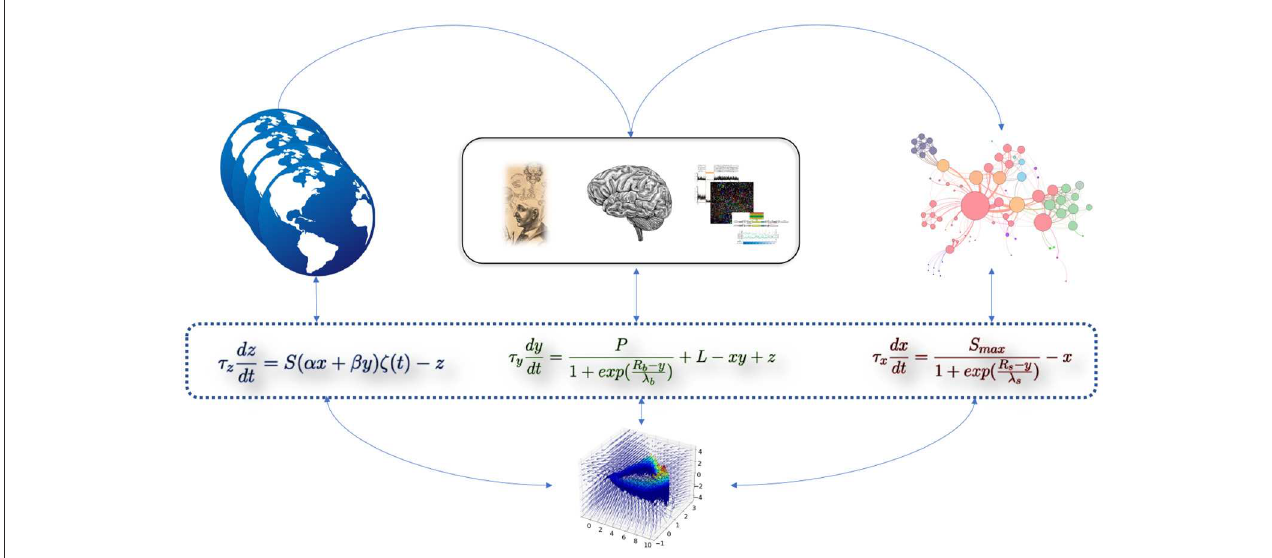
FIGURE1 Cartoon representation of the computational dynamical toy-model of psychiatric disorders. The three equations are intrinsically linked by their interacting variables. The equation on the left (variable z ) represents the effect of the external environment as perceived by the patient. The equation in the middle (variable y ) represents the aggregation of internal elements (e.g., biological). The equation on the right (variable x ) represents the intensity of symptoms. Empirical or simulated data can be “included” in these abstract variables (i.e., their precise identification does not change the model and its dynamics). The 3-dimensional phase space at the bottom of the figure corresponds to the toy-model presented in this